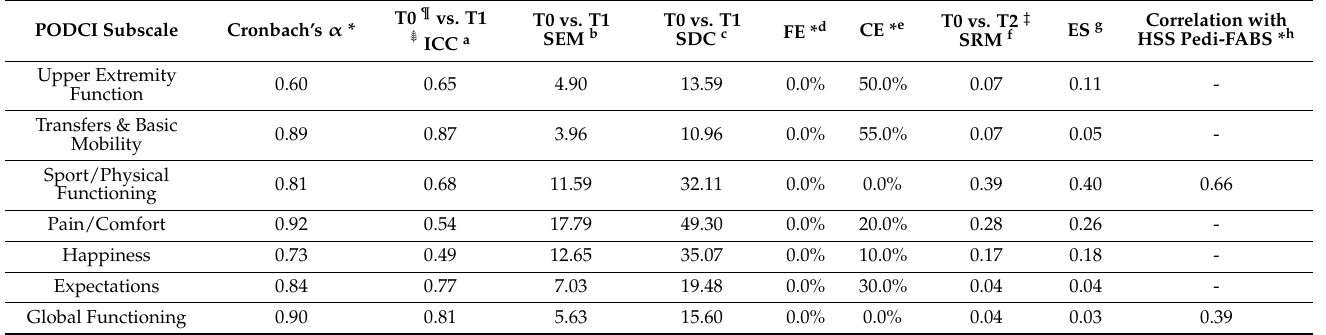
Table 3. Psychometric properties of Pediatric Outcome Data Collection Instrument (PODCI) Parent- reported form ( n = 20). Table 1. Patient demographics and clinical